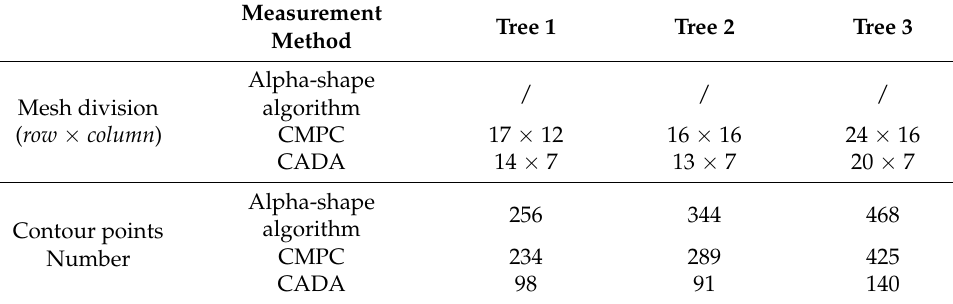
Table 8. Contour extraction using different